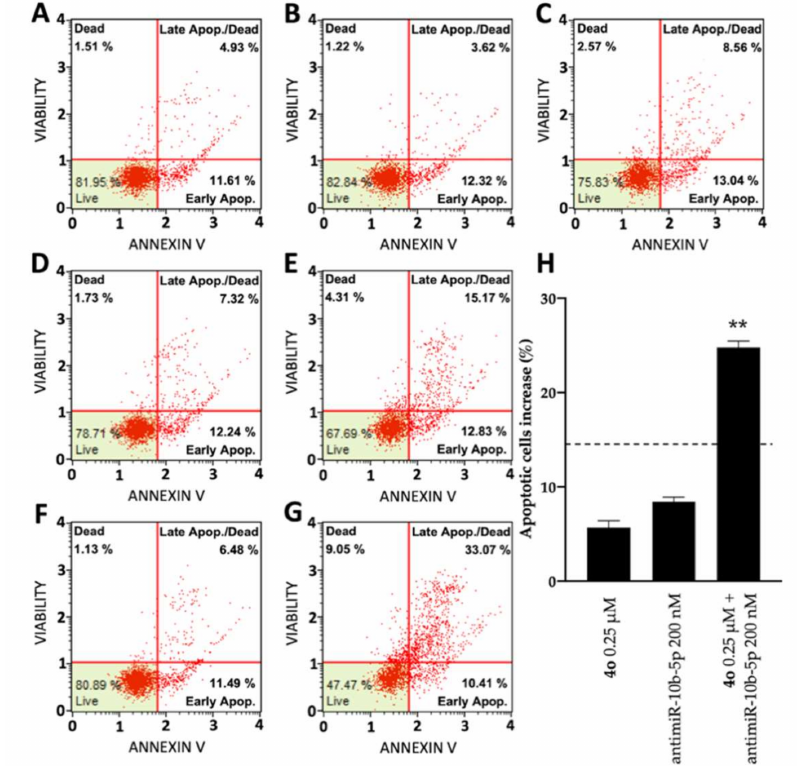
Figure 6. Effects of compound 4o and antimiR-10b-5p on U251 apoptosis: Annexin V assay. Apoptosis was assayed after 72 h culture. ( A ) Untreated control cells; ( B ) cells treated with DMSO; ( C ) cells treated with 0.25 µ M compound 4o ; ( D ) cells treated with lipofectamine; ( E ) cells treated with 200 nM antimiR-10b-5p; ( F ) cells treated with DMSO and lipofectamine; ( G ) cells treated with combined administration of 0.25 µ M compound 4o and 200 nM antimiR-10b-5p. ( H ) summary including results representing % of apoptotic cells of U251 cultures treated as indicated. Results represent mean ± SD ( n = 3). The dotted line represents the sum of the values obtained with single administrations of the compounds. p < 0.01 (**; highly